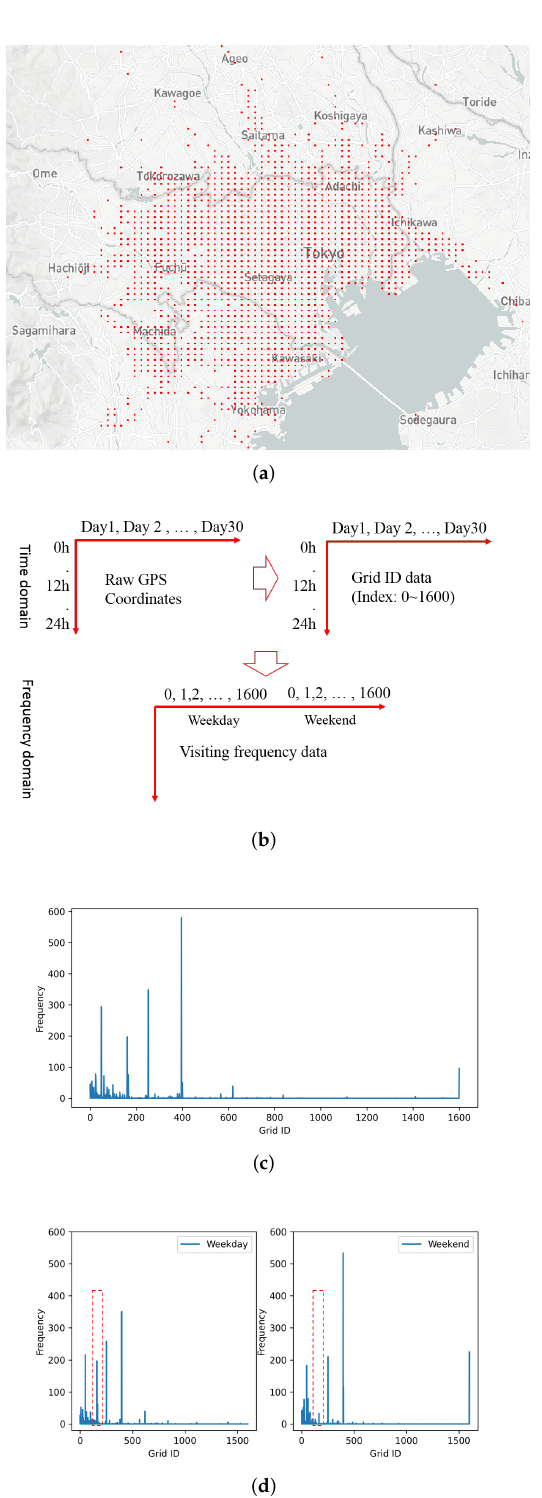
Figure 2. Illustration of travel-frequency pattern preprocessing. ( a ) Grid distribution. ( b ) The procedures of preprocessing. ( c ) Travel pattern without distinguishing weekday from weekends. ( d ) Travel pattern distinguishing weekdays from